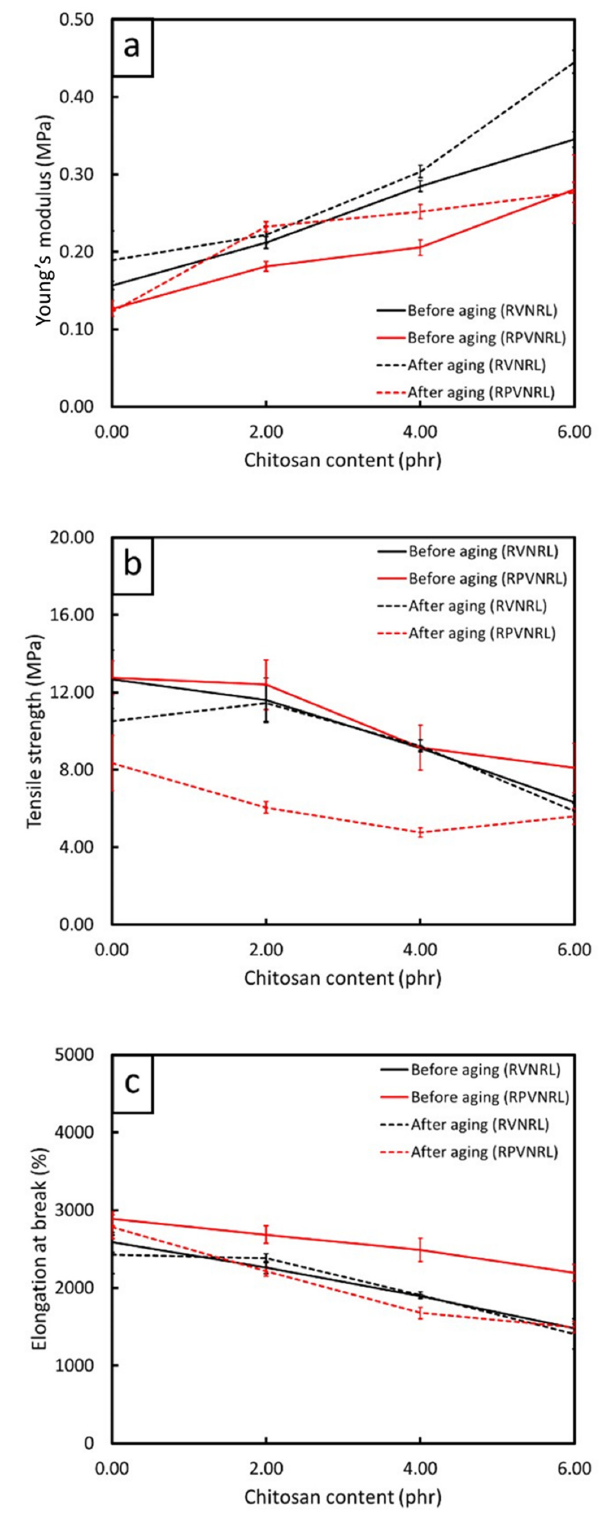
Figure 4. ( a ) Young’s modulus (tensile modulus at 500% elongation), ( b ) tensile strength, and ( c ) elongation at break of non-aged and thermal-aged CS/R-VNRL and CS/RP-VNRL composites, with varying CS contents of 0, 2, 4, or 6 phr. Error bars indicate ± standard deviation.